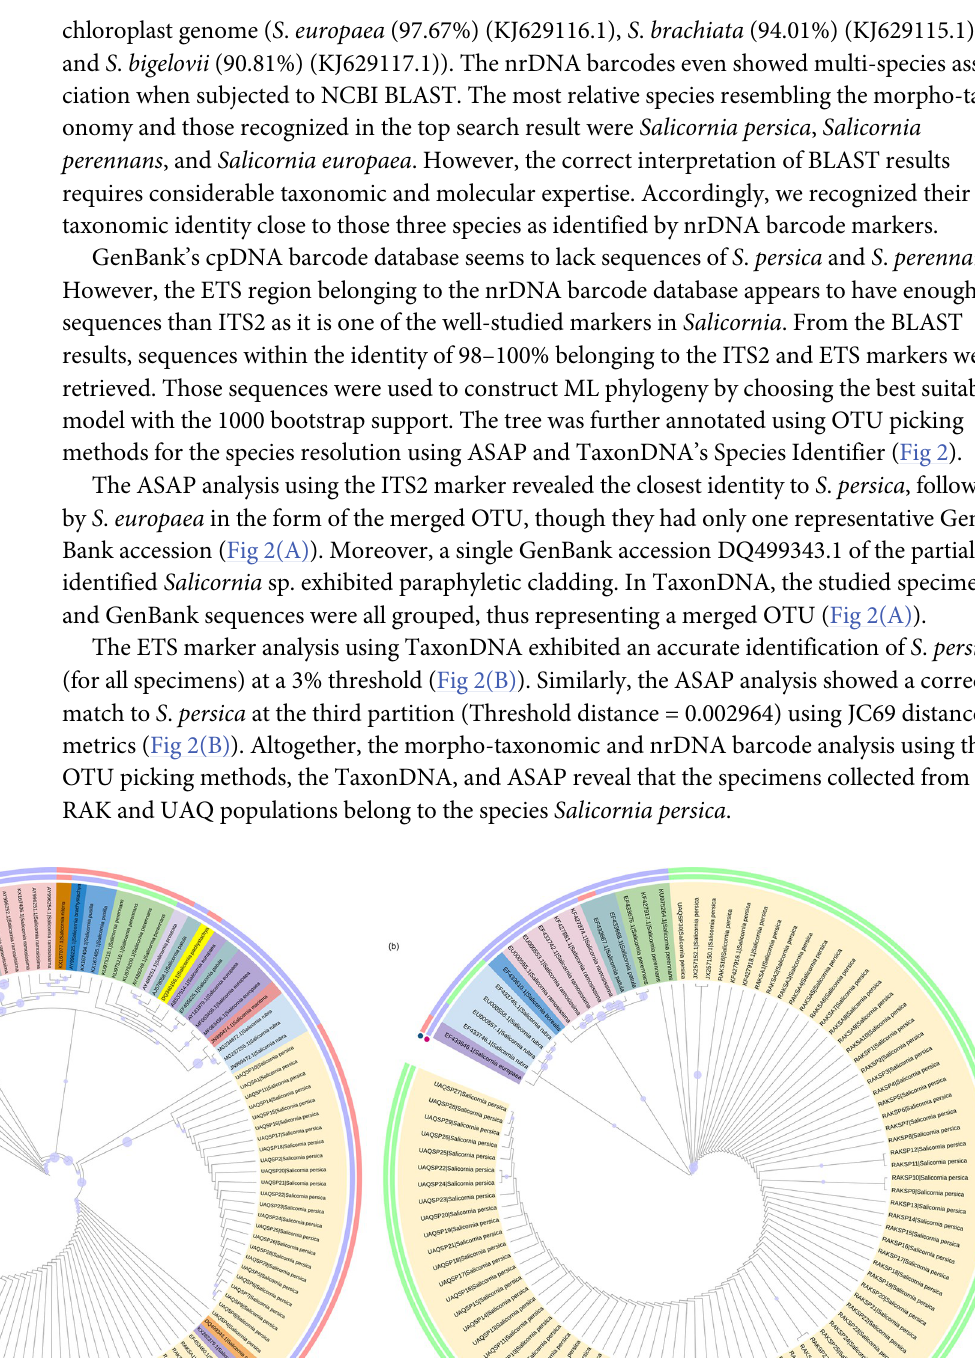
PLOS ONE | https://doi.org/10.1371/journal.pone.0270463 July 27,